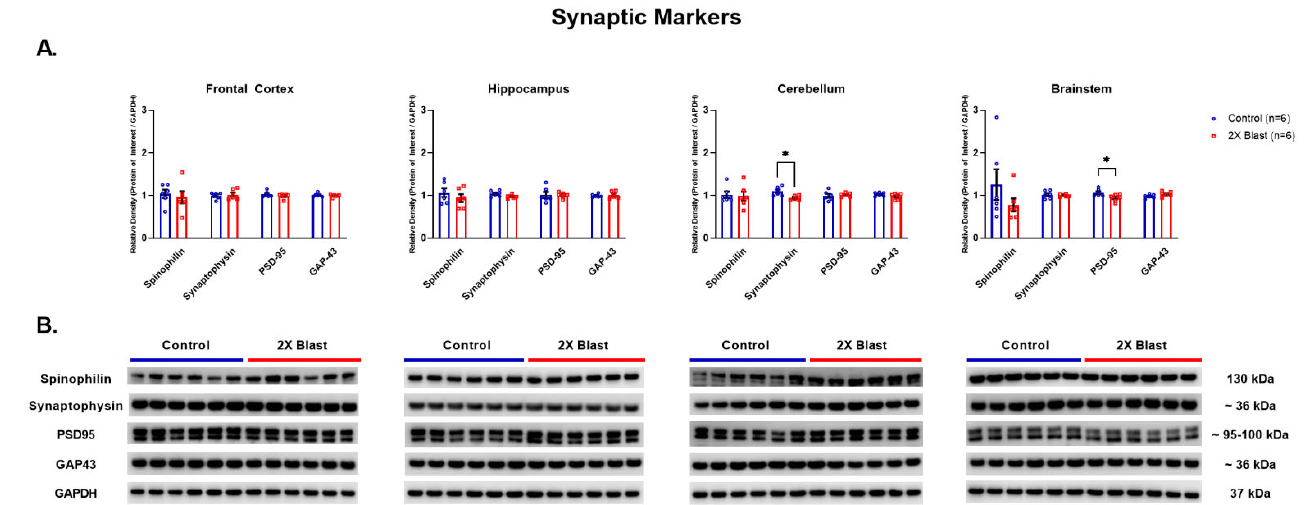
Figure 1. Synaptic related protein expression changes. ( A ) Densitometric ratio of the levels of Spinophilin (single band at 130 kDa), Synaptophysin, PSD-95 (both visible bands evaluated together) and GAP-43 with respect to GAPDH as measured in FCtx, H, CRB and BS 15 days following an explosive-driven double blast exposure, n = 6 per group, * indicates p values < 0.05 as determined by 2-tailed, unpaired t -tests. Error bars represent standard error of the mean (SEM). ( B ) Representative western blots # for each antibody used. All gels were run in triplicate and data represents the average of 3 runs per sample. # For full length blots, see Supplementary Figures S1–S4.